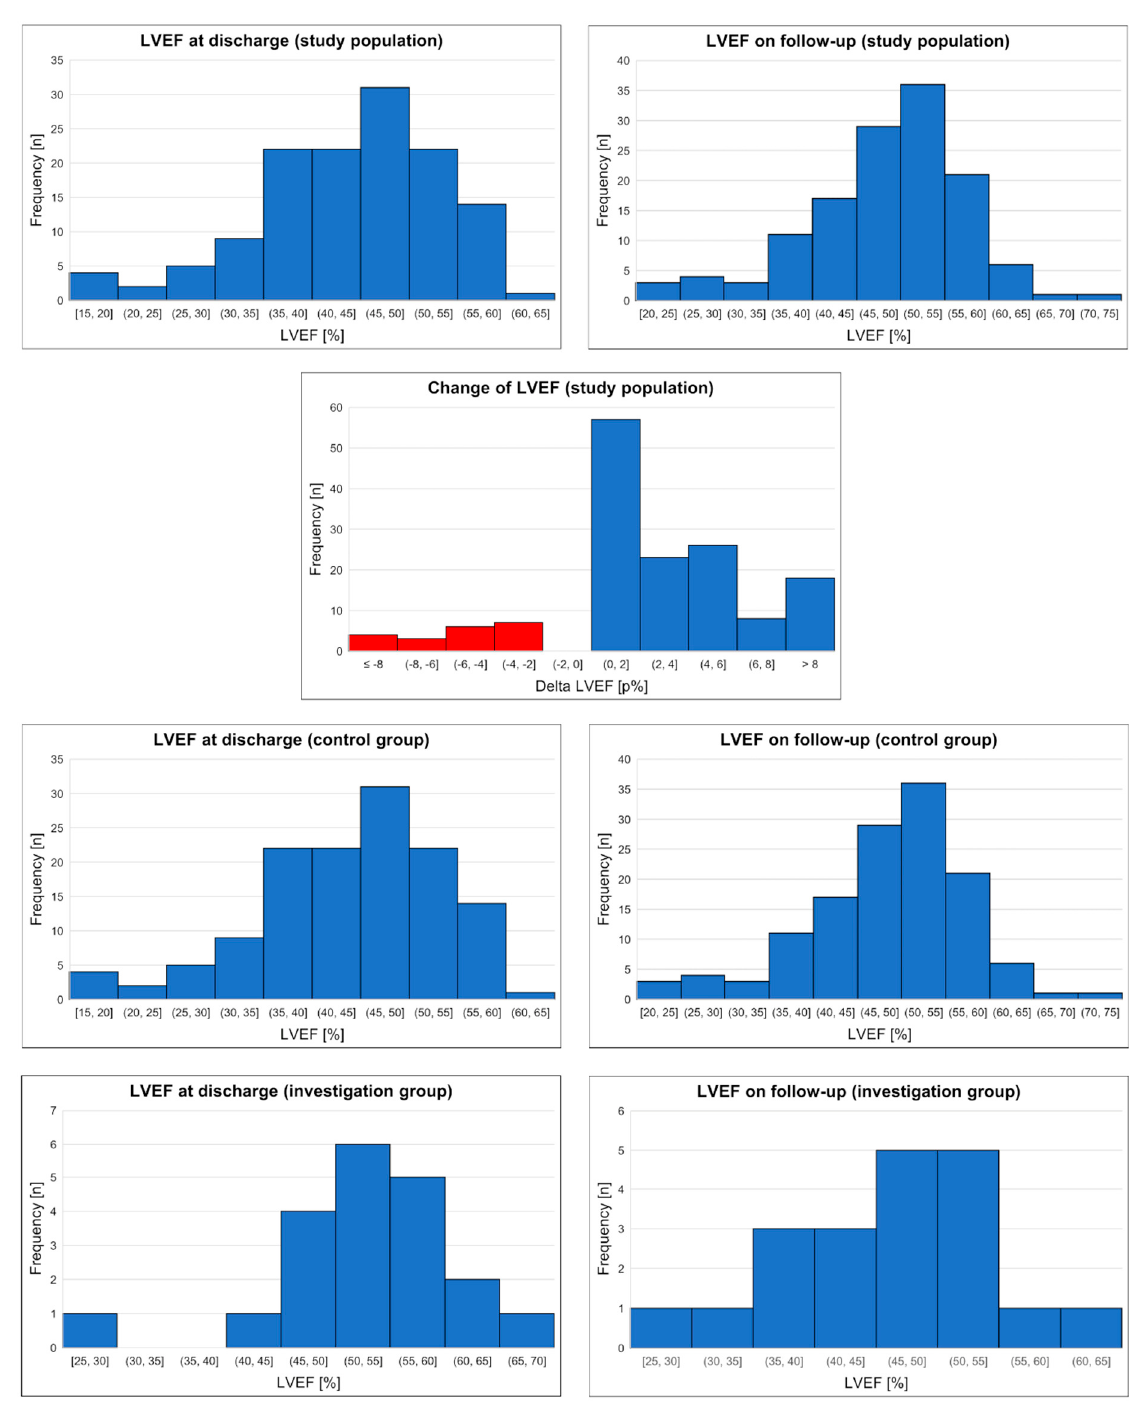
Figure 1. Histograms of LVEF among study populations, P/I-LVEF group and D-LVEF group. (left ventricle ejection LVEF (left ventricle ejection fraction).